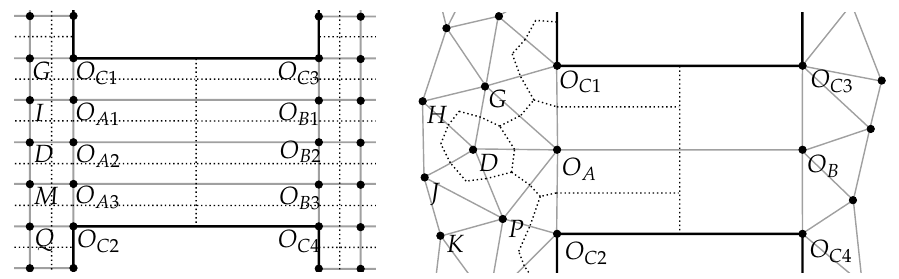
Figure 4. Structured mesh with multiple orifice element pairs ( left ) and unstructured mesh with three orifice element pairs ( right